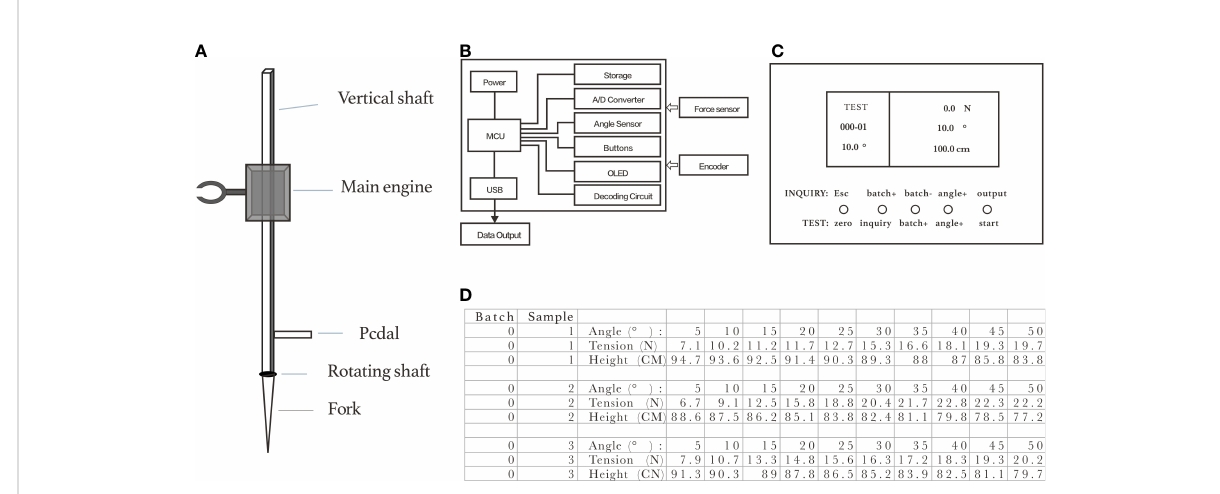
FIGURE 4 The physical appearance, major components and export data format of lodging resistance tester in situ for maize. (A) Tester structure: it consists of the main engine, vertical shaft, rotating shaft, pedal and fork head. The vertical shaft is connected to the fork head through the rotating shaft, and the pedal is located at the lower part of the vertical shaft. The test host can slide up and down along the vertical bar. (B) Electronic system: the main engine integrates the angle, tension, and height sensors, which is controlled by microcontroller. The angle sensor uses a single-axial gyroscope, output to MCU through I2C port, with accuracy of 0.1°; the tensile sensor adopts an S-type tension integrated weighing sensor, output voltage signal into digital signal to MCU through AD conversion, with accuracy of 0.1 N; the height sensor adopts a displacement encoder, transmitted to MCU, measuring reference to the bottom end of vertical rod rotating shaft, with accuracy of 0.1 cm. Other types of sensors can also be connected to this device. The power supply device comes from the charging lithium battery, which can power the device for more than six hours. (C) User interface: consists of a 3.5-inch LCD screen and fi ve selection buttons at the bottom of the device. These fi ve buttons integrate the two functions of preparation mode and query mode. The user interface is written in the C programming language. (D) Export data format: each set of data has three group values: angle, force, and displacement (distance between vertical line and the rod of the tester). After the test ends, import the data into the U disk in a XLS fi le